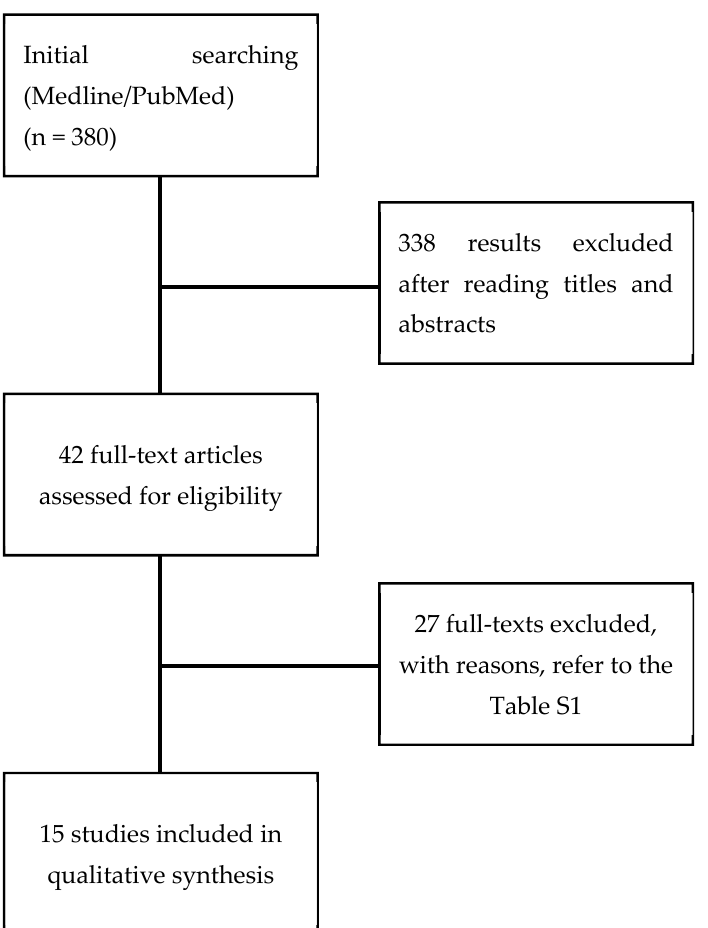
Figure 1. Diagram of the systematic review of literature. Table 3. Risk of bias of included